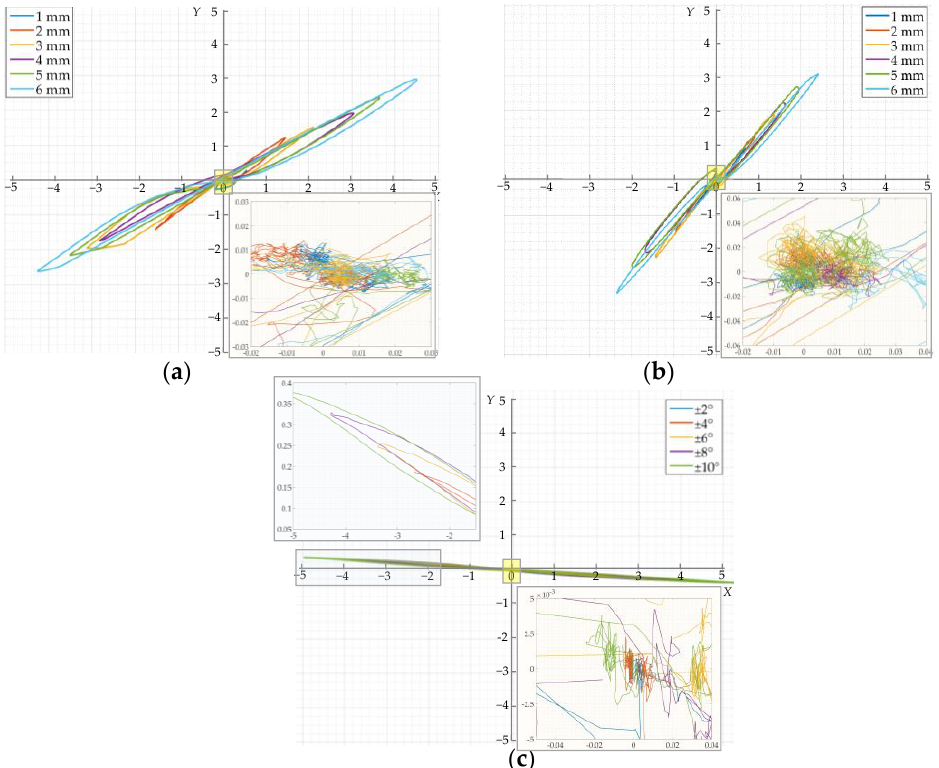
Figure 12. Amplitude–phase composite figure of the experimental signals: ( a ) Amplitude–phase composite figure of the circumferential crack detection signals; ( b ) Amplitude–phase composite figure of the axial crack detection signals; ( c ) Amplitude–phase composite figure of the sensor jitter signals.